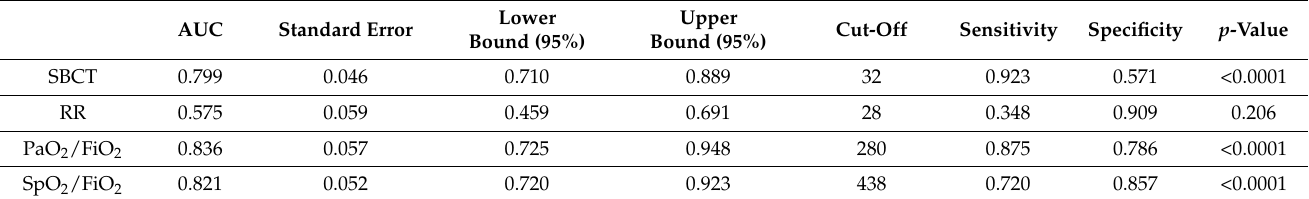
Figure 1. ROC curve analysis of PaO 2 /FiO 2 ( a ), SBCT ( b ), Respiratory Rate ( c ) and SpO 2 /FiO 2 ( d ) as predictors of NIRS requirement. Tests performed in all included patients. Abbreviations: NIRS, non-invasive respiratory strategies; SBCT, single-breath counting test. Table 2. ROC curves results of factors which might predict NIRS requirement. Tests performed in all included